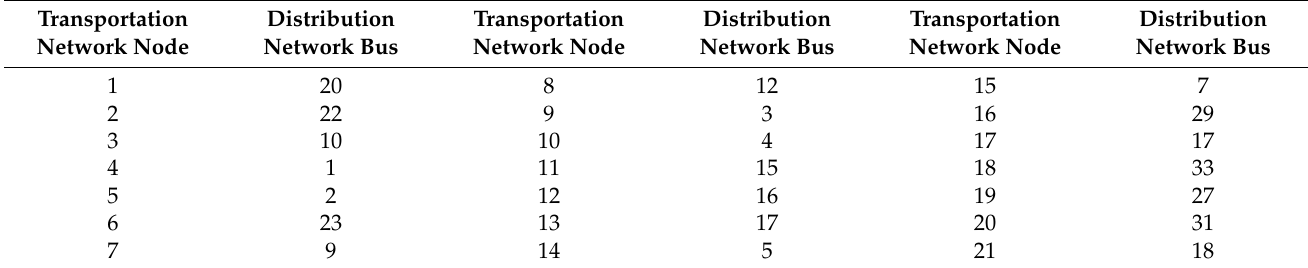
Table 1. Coupling nodes in transportation and distribution network.